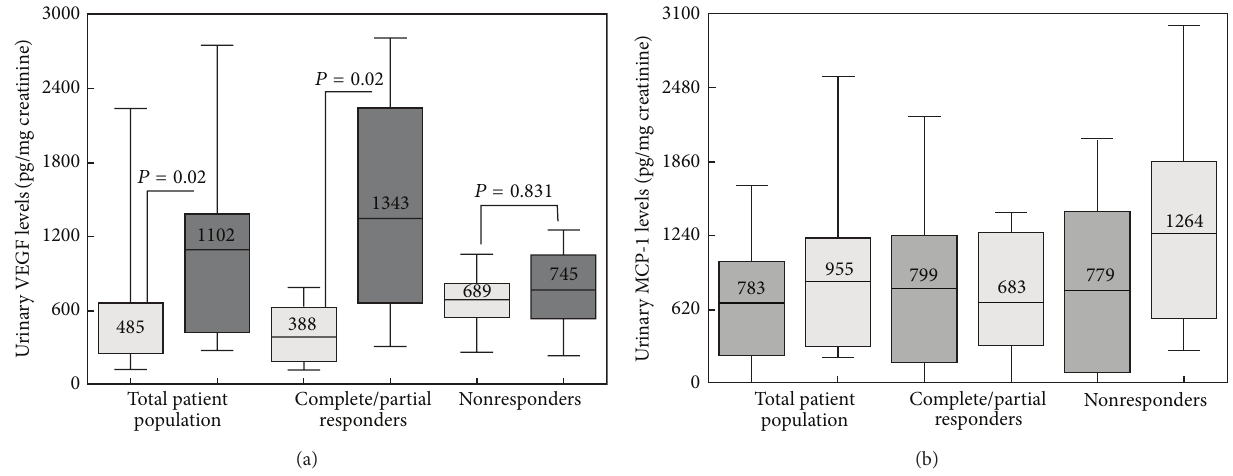
Figure 5: The change in urinary VEGF levels among the total group, complete and partial responders, and nonresponders. Urinary VEGF was significantly increased in patients demonstrating complete or partial reduction in urinary protein. (b) The change in urinary MCP-1 levels among the total group, complete and partial responders, and nonresponders. Urinary MCP-1 was unchanged by ACTH